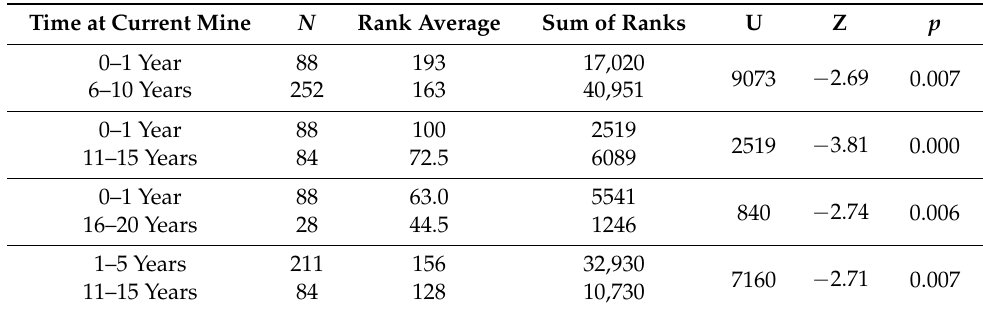
Table A7. Mann-Whitney results for mining experience and confidence in one’s ability to correctly explain or demonstrate “how to reestablish ventilation”.